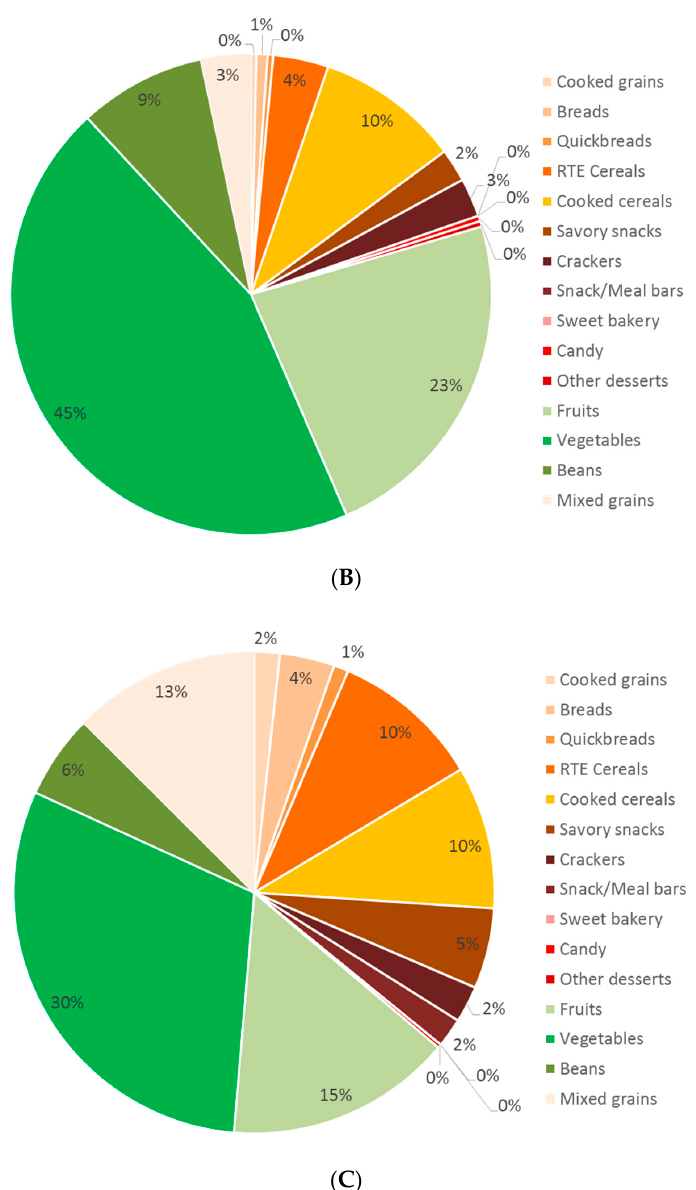
Figure 2. Distribution of higher-quality carbohydrate foods by food group. The three models are: ( A ) 10:1:1 carb:fiber:free sugar; ( B ) CFQS-4: comprised of fiber, free sugar, sodium, and potassium, and ( C ) CFQS-5: comprised of fiber, free sugar, sodium, potassium, and whole grains ( N = 2596).